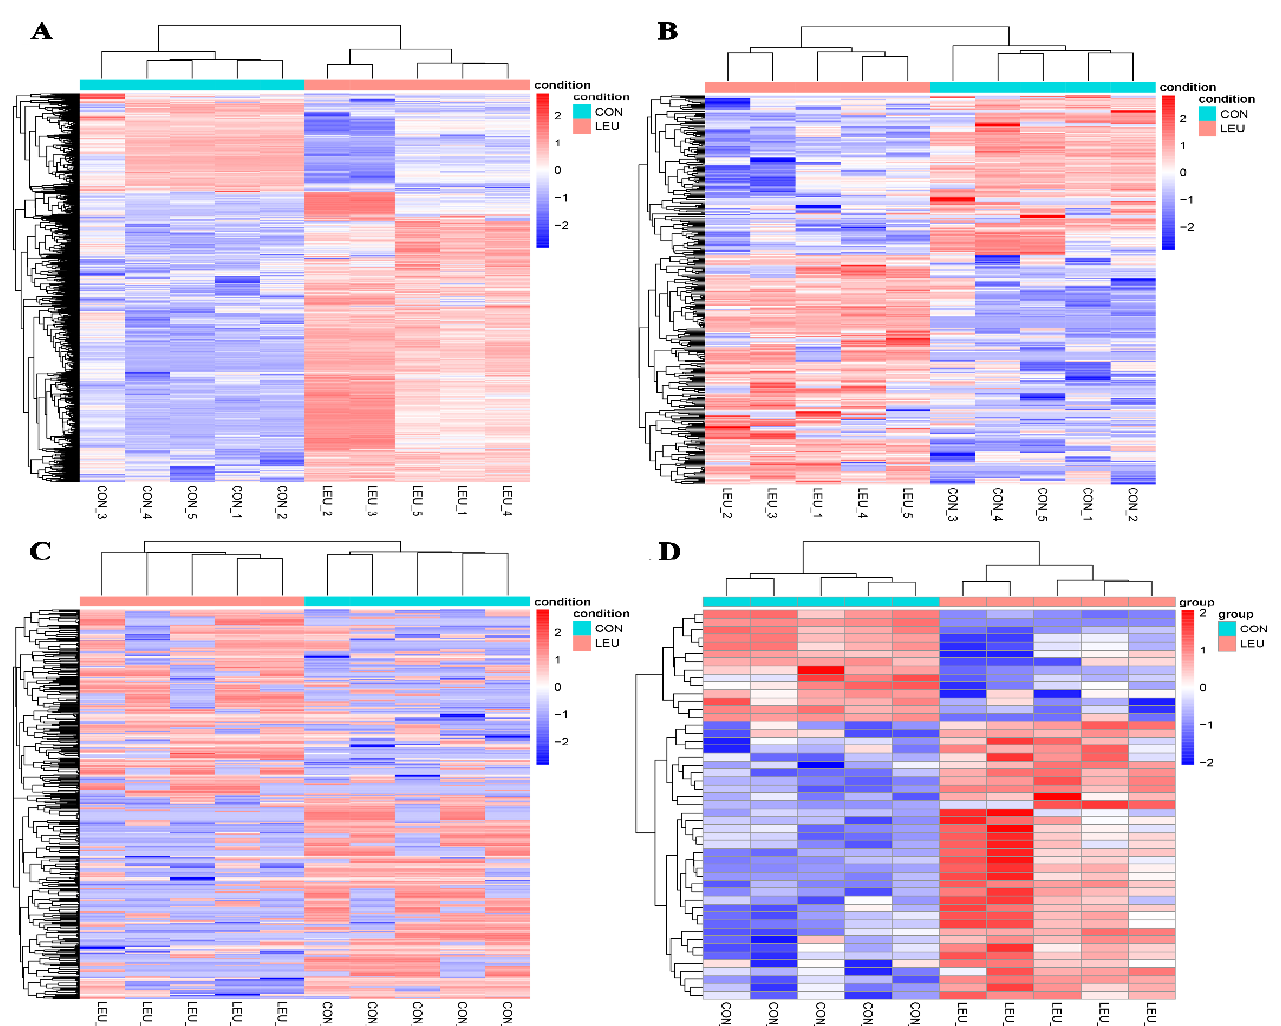
Figure 5. Heatmaps of Differentially Expression Molecules. ( A ) Heatmaps of differentially expressed mRNAs; ( B ) differentially expressed lncRNAs; ( C ) differentially expressed circRNAs; ( D ) differentially expressed miRNAs.